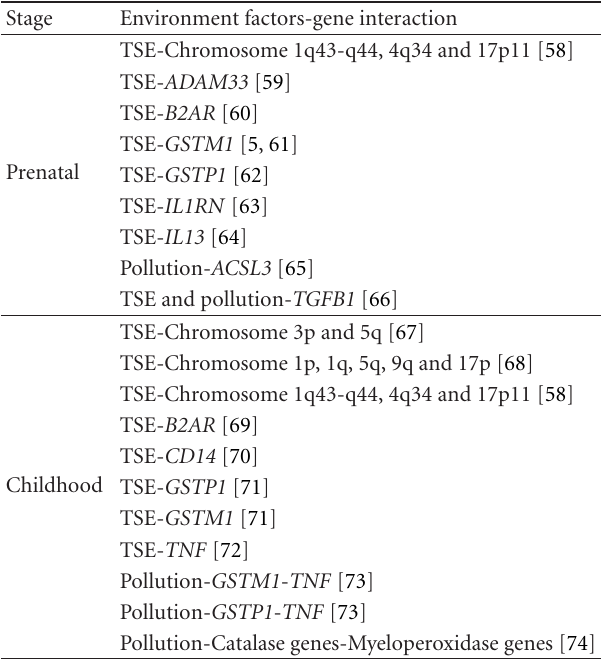
Table 3: Interactions of genes with perinatal environmental TSE and pollution on asthma